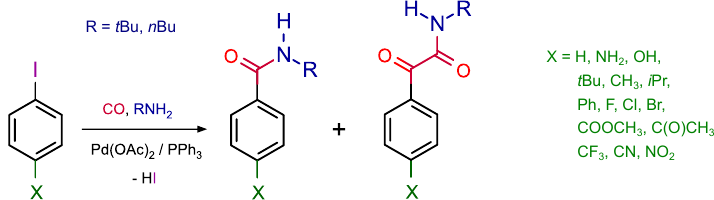
Figure 2. Aminocarbonylation of 4-substituted iodobenzenes